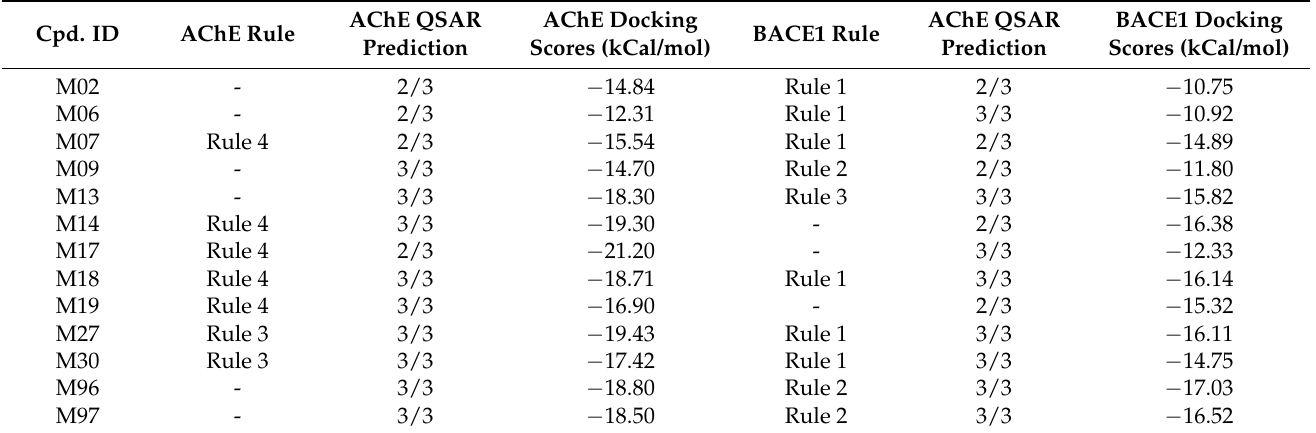
Table 6. Predictions of the designed inhibitors targeting AChE and BACE1